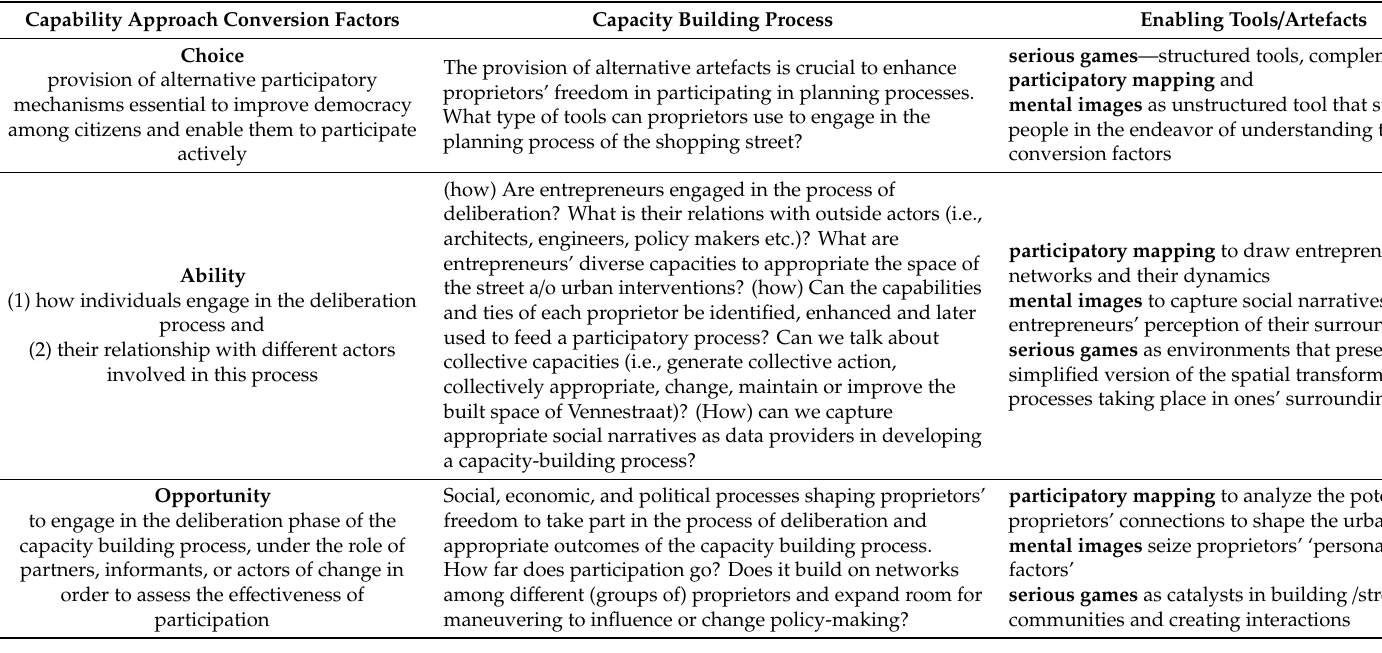
Table 2. Summary of interactions betWween the Capability Approach language, the capacity building process, and enabling